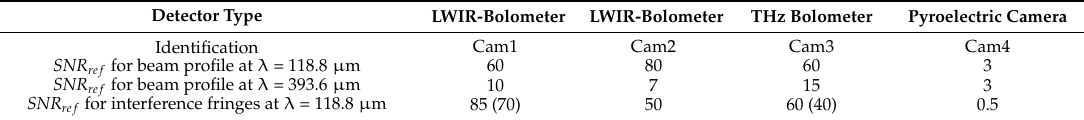
Table 2. Results of SNR ref for the cameras at a terahertz (THz) power of P ref = 10 mW and an integration time of τ ref = 25 ms. Numbers in brackets correspond to values obtained with an IR-filter in front of the